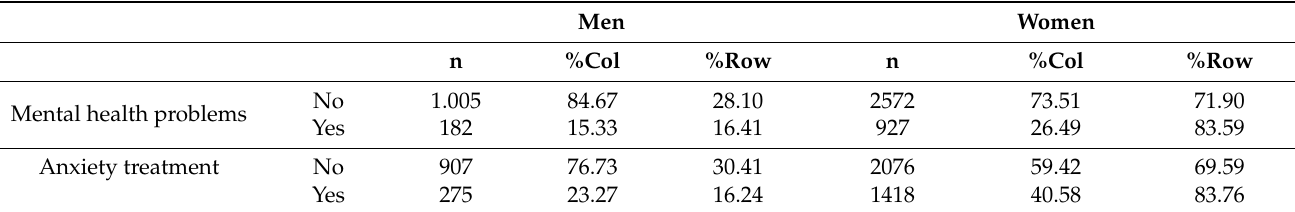
Table 6. Relationship between mental health, anxiety treatment, and gender.